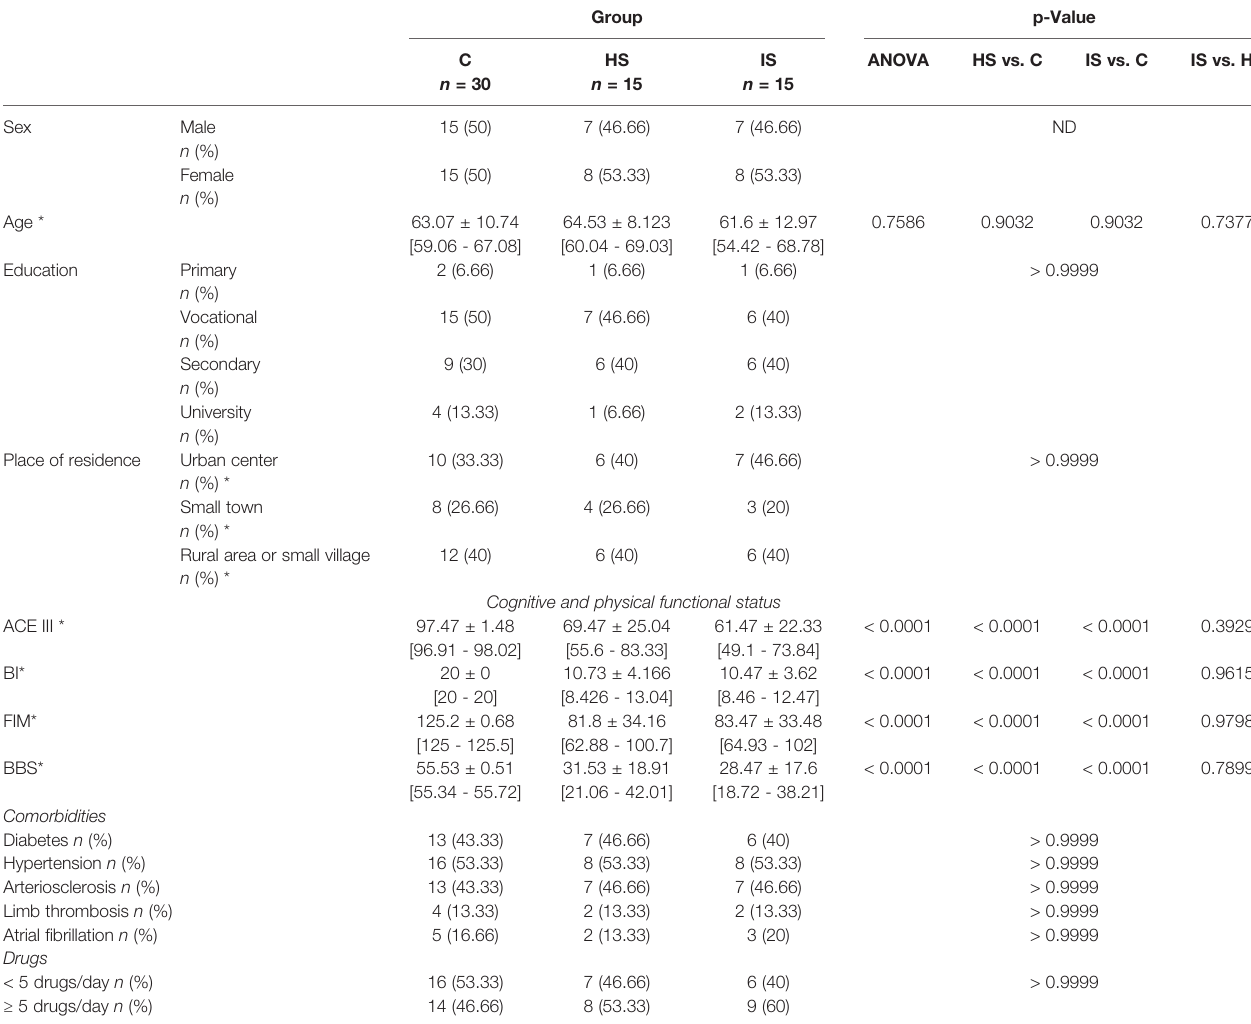
TABLE 2 | Clinical characteristics of the studies and control groups.